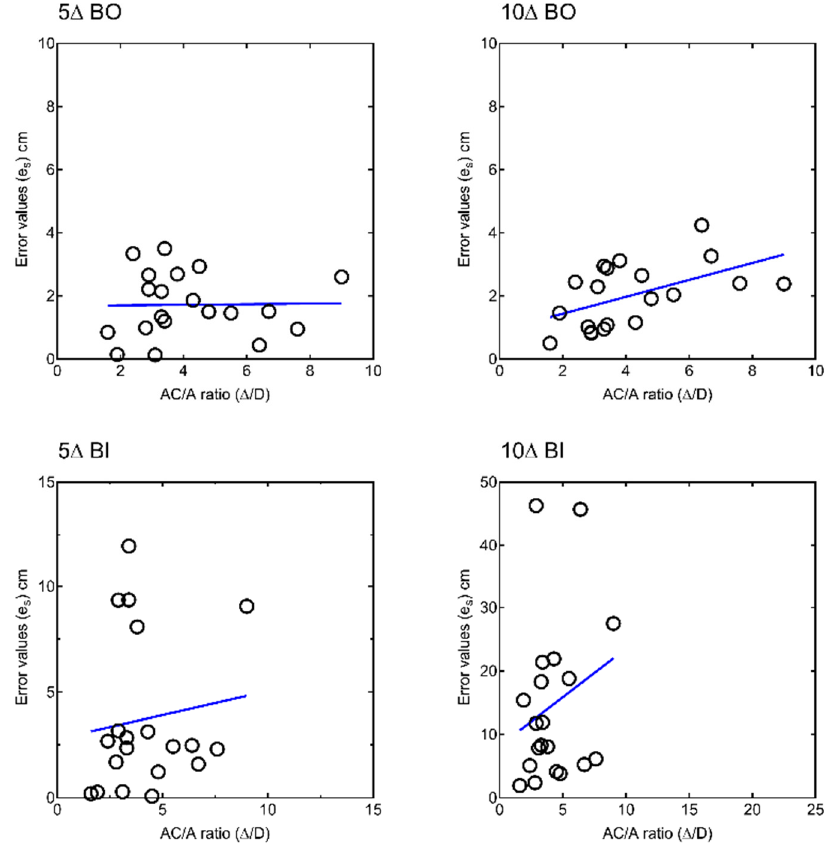
Figure 3. Correlation of accommodative ‐ convergence over accommodation (AC/A) ratio and stereo ‐ localization accuracy ( e s ) for each vergence demand (BO: Base out; BI: Base in). For visualization purposes, axes are not drawn at the same scale. Individual data points are shown as empty bullets.